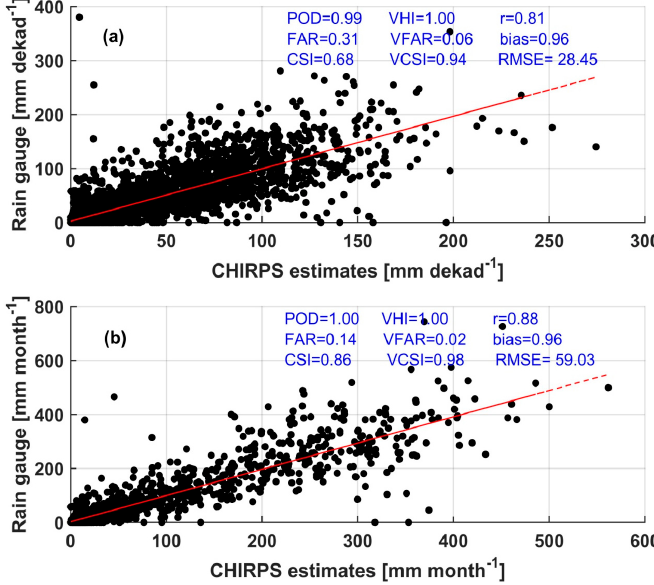
Figure A1. Scatter plot between rain gauge observations and CHIRPS rainfall estimates at dekadal ( a ) and monthly ( b ) temporal scale over the Upper Blue Nile basin for the period of 2000–2015. Probability of detection (POD), false alarm ratio (FAR), critical success index (CSI), volumetric hit index (VHI), volumetric false alarm ratio (VFAR), volumetric critical success index (VCSI), correlation coefficient (r), bias, and the root mean square error (RMSE). The perfect score for POD, CSI, VHI, VCSI and bias is 1, while 0 is the perfect score for FAR and VFAR. The RMSE values are presented in millimeters (mm) (See Ayehu et al., 2018 for the details of the analysis).